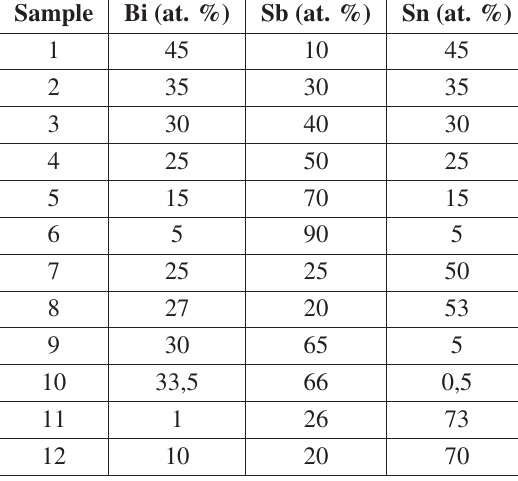
Table 4. Chemical composition of the investigated alloys.